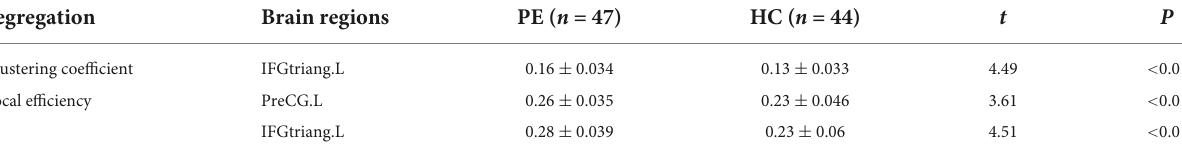
TABLE 2 Brain regions with abnormal nodal segregative parameters between PE and HC groups.